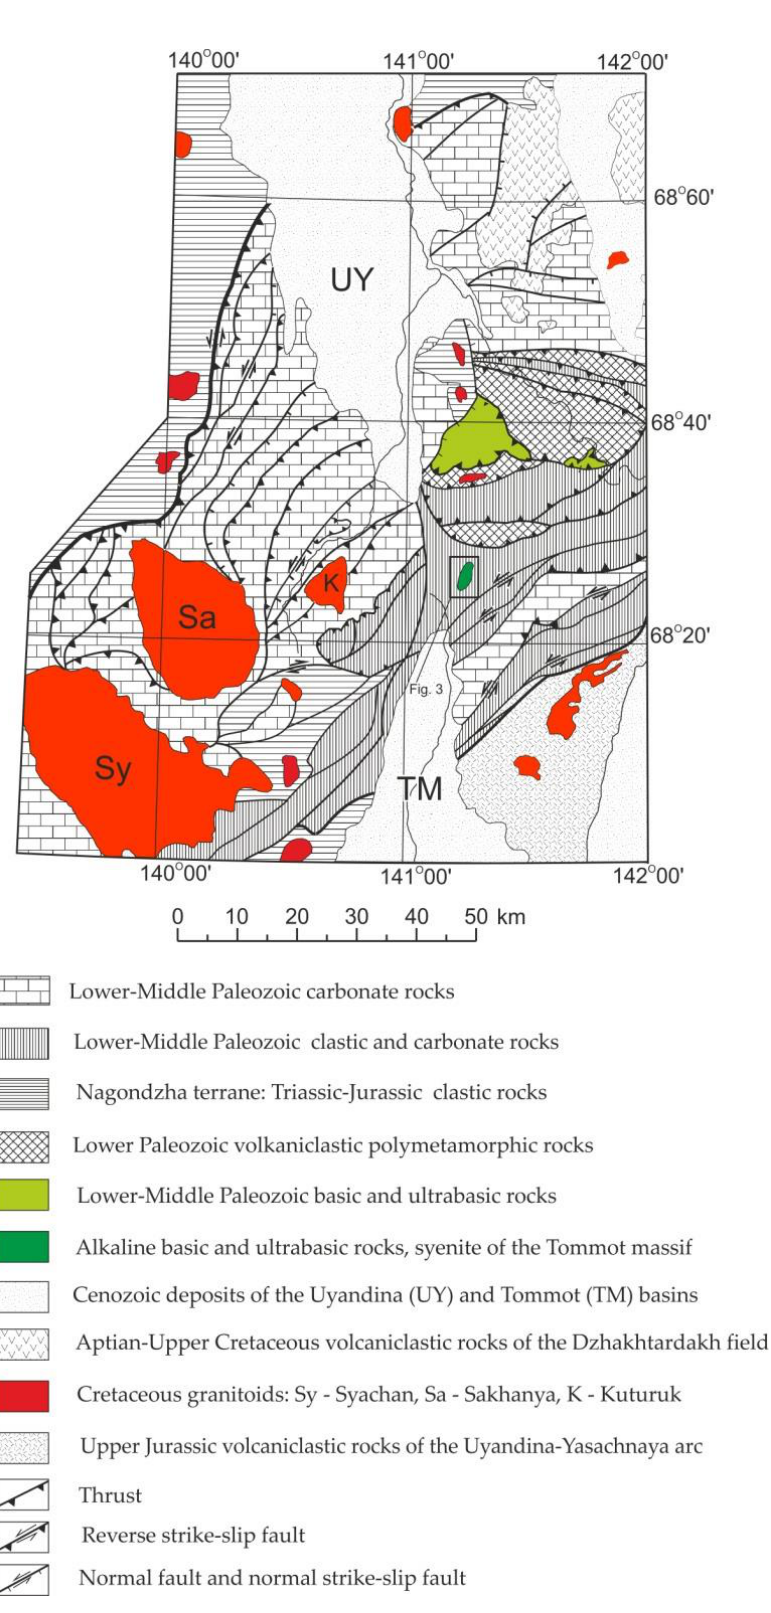
Figure 2. Geological sketch map of the Selennyakh block of the Omulevka terrane [modified 23]. For location, see Figure 1.